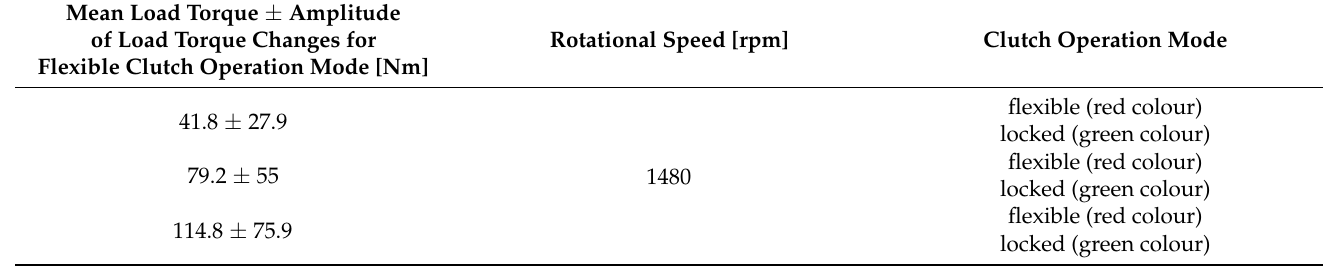
Table 1. Summary of test